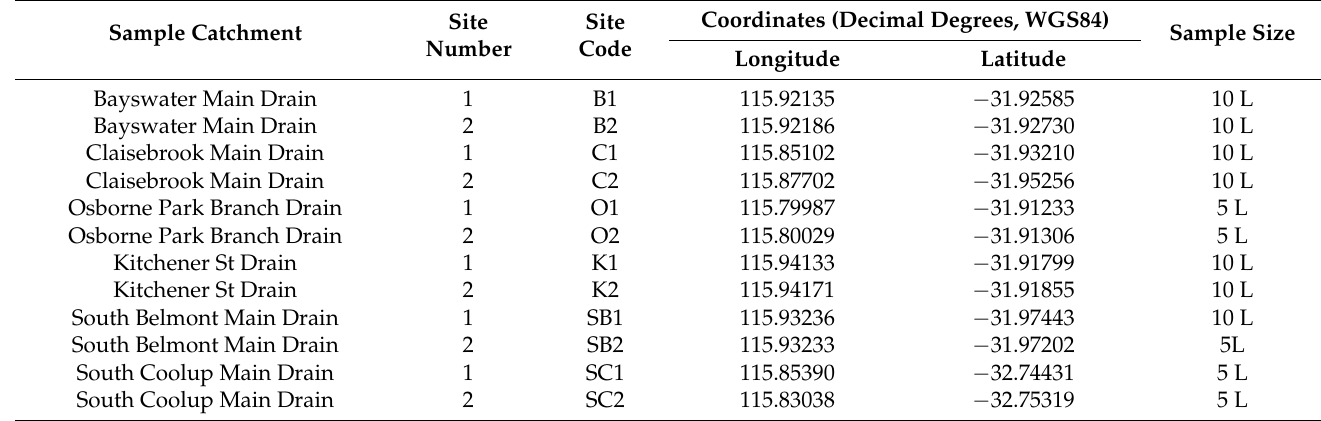
Figure 1. The drainage systems sampled, showing sample locations, catchment boundaries and land use categories. Table 1. Sampling location details and the volume of water taken at each site. Two sites were selected at each drain system, denoted Site Number 1 and 2. All samples 3 repeats, 250 mL